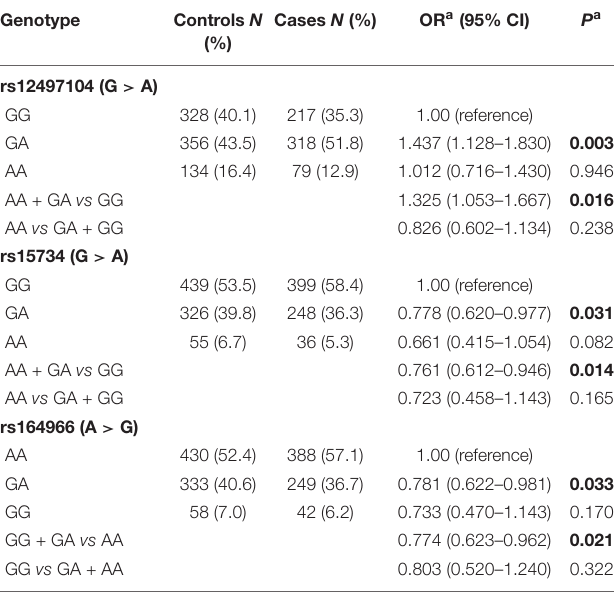
TABLE 1 | Association between the candidate single nucleotide polymorphisms (SNPs) of linc00312 and nasopharyngeal carcinoma (NPC) susceptibility was analyzed by multivariate logistic